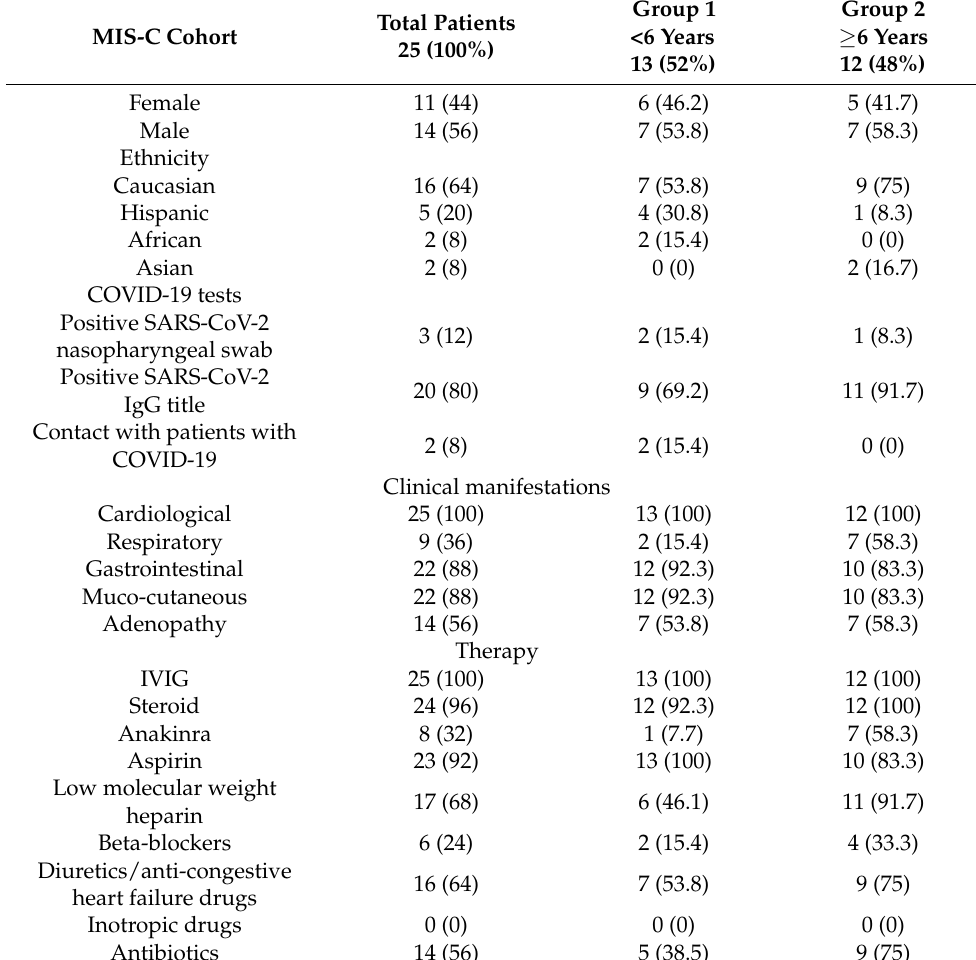
Table 1. Demographics, clinical features, COVID-19 tests and therapy of MIS-C patients, according to different age groups. Group 1: <6 years old (No. 13); group 2: ≥ 6 years old (No. 12). MIS-C: multisystem inflammatory syndrome in children.